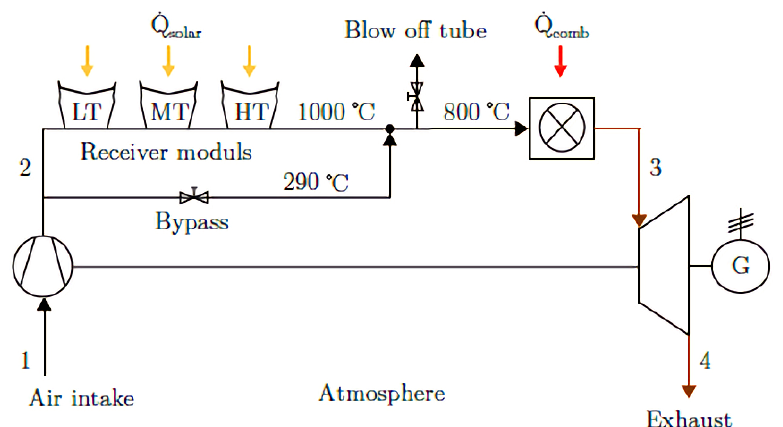
Figure 3. Scheme of SOLGATE solar-driven Brayton cycle. Adapted from [28] (LT: Low Temperature; MT: Medium Temperature; HT: High Temperature; 1: air inlet from atmosphere; 2: Compressed air; 3: air outlet from combustor; 4: exhaust air from turbine).